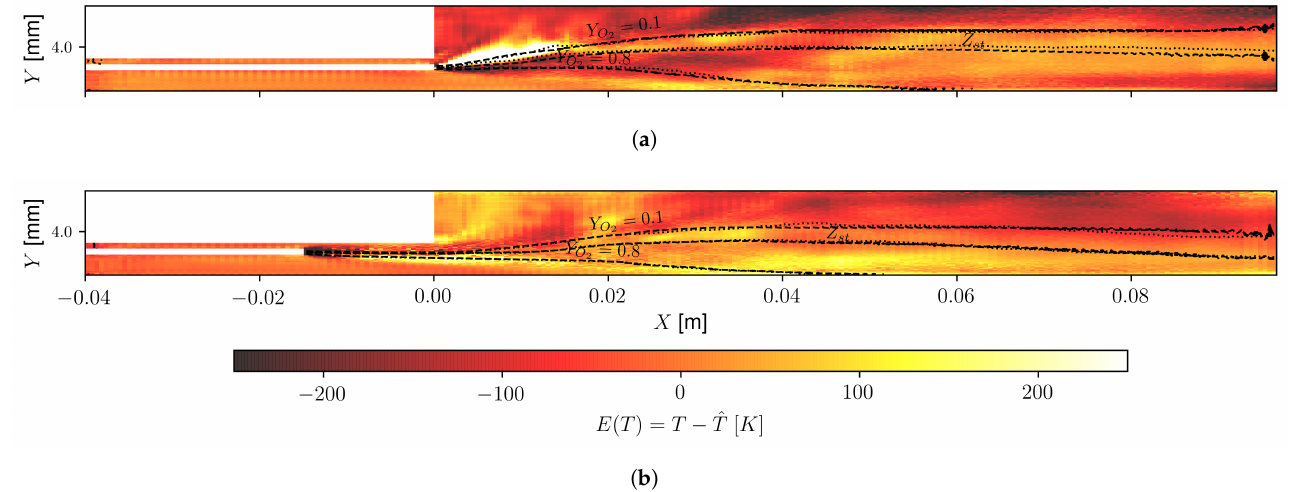
Figure 10. Predictive error in T field of the U-Net with respect to LES-interpolated data. Predicted and ground-truth lines are shown in dashed and dotted patterns, respectively. ( a ) DP-A and ( b ) DP-C. The color-scale has been deliberately saturated to ( − 250 K, 250 K) to better distinguish regions with prediction errors. For reference, 250 K is ∼ 7.5% of the O 2 -CH 4 adiabatic flame’s temperature. The aspect ratio of the figures has been modified purposely to facilitate their